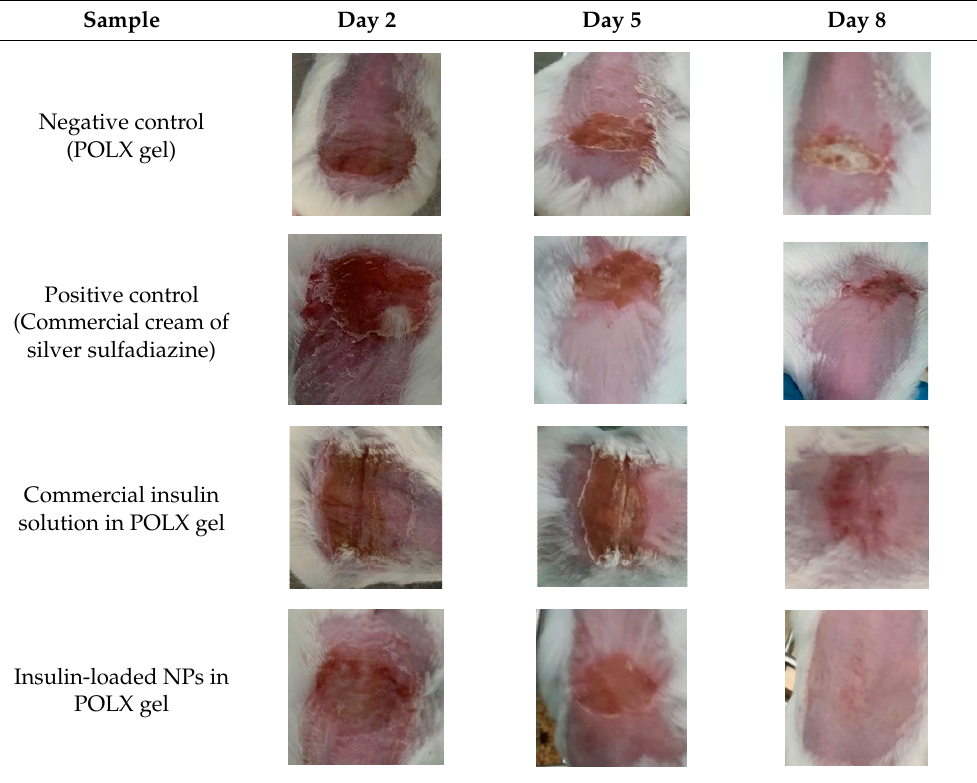
Figure 10. Skin thickness after skin burn chemically induced (3-days period) and during the 5-days of treatment: POLX gel (black triangles), commercial cream of silver sulfadiazine (black circles), insulin solution in POLX gel (grey squares), and insulin-loaded NPs in POLX gel (dark squares). Table 3. Representative monitorization of the macroscopic appearance of the wounds on the 2 nd , 5 th , and 8 th days after chemical burn induction.